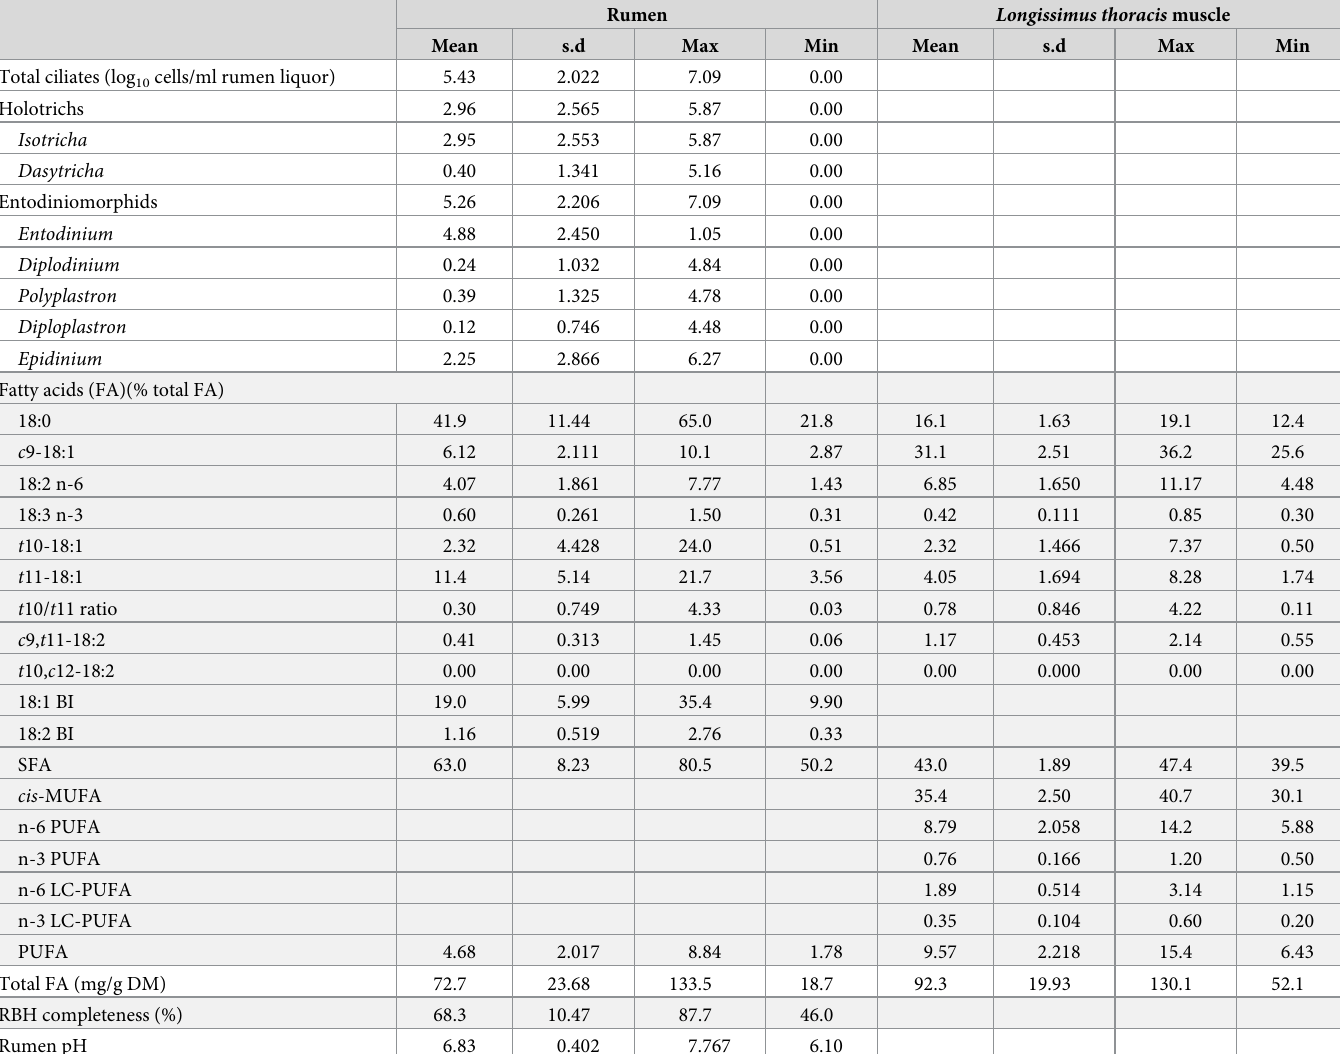
Table 4. Mean, standard deviation, minimum and maximum values for the phenotypes identified in Experiment